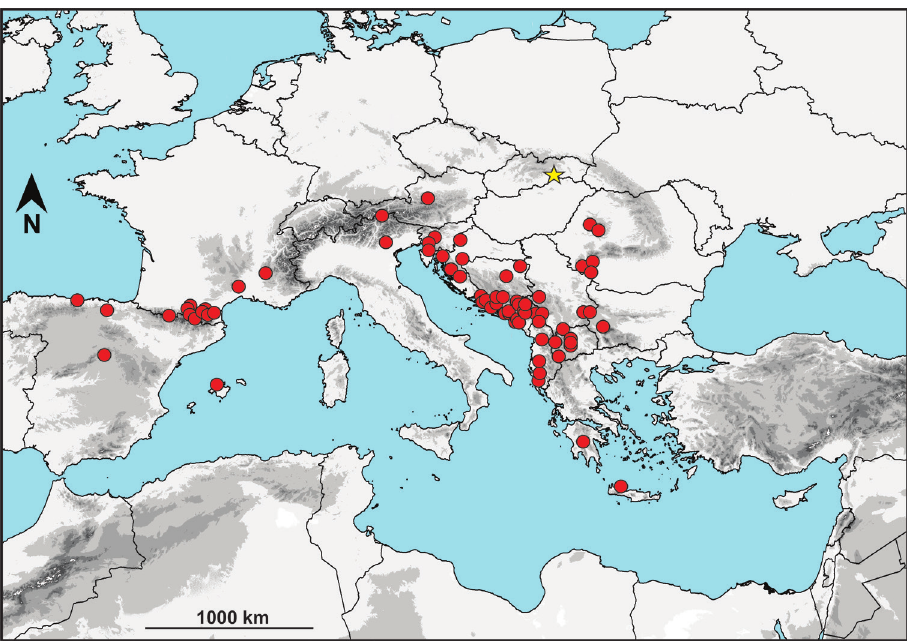
Figure 1. Distribution of the subgenus Blothrus in Europe. Red circles represent type localities of species. Yel- low star indicates the northernmost occurrence of the subgenus in Slovakia ( Neobisium slovacum